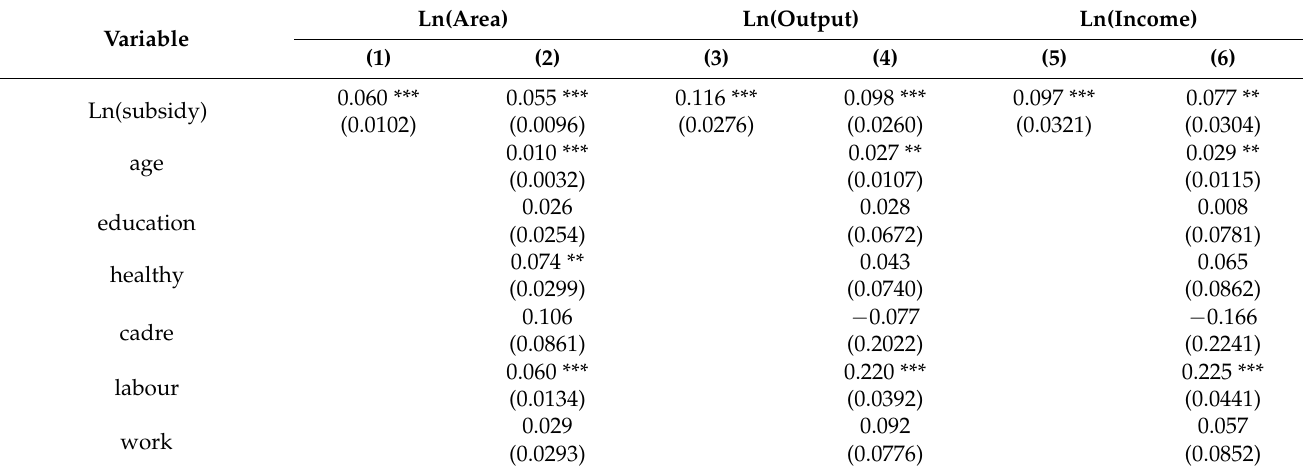
Table 2. Benchmark regression